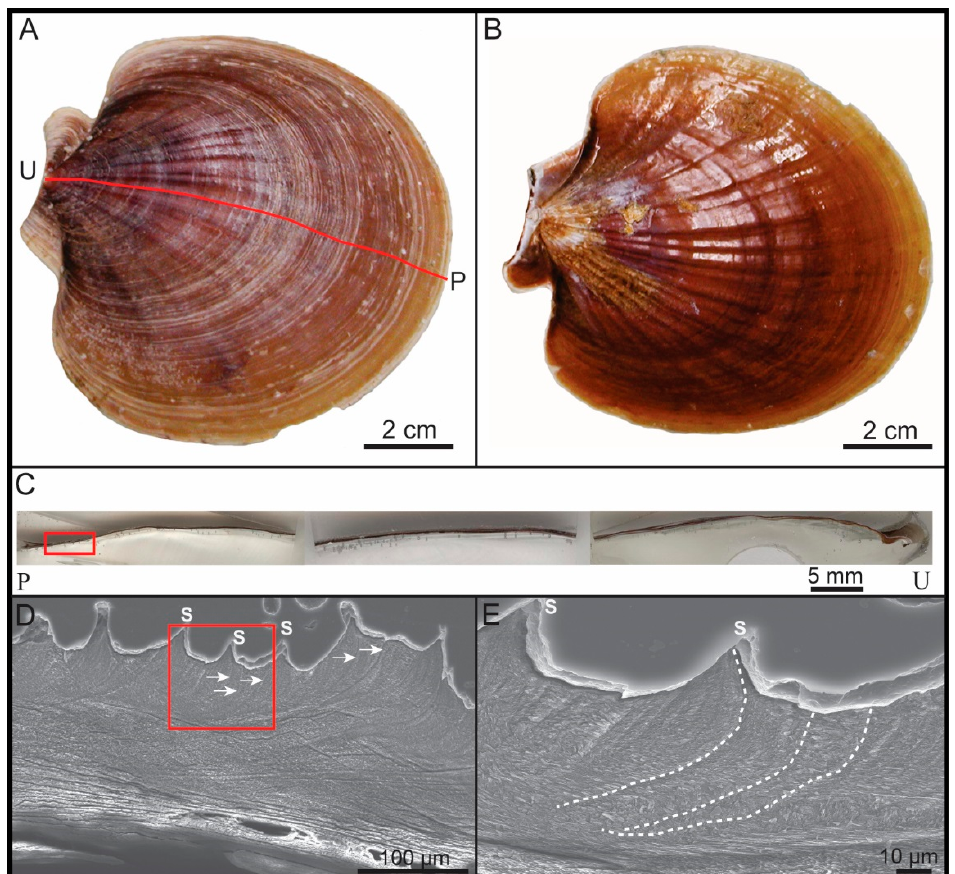
Figure 1. Antarctic scallop ( Adamussium colbecki ) shell. ( A ) Top view of a right valve used in this study. Note: the red line marks the section taken along the shell length from the umbo region (U) to the posterior region (P). ( B ) Image of the shell interior of the same valve. ( C ) Shell regions polished and prepared for SEM (Scanning Electron Microscopy) and APT analyses. Note: The red rectangle marks the location of the shell analyzed. ( D ) SEM image of the shell surface showing the locations of surficial striae (S) and substrial growth lines (white arrows). ( E ) Detailed view of some substrial growth lines (dashed lines) from the marked area (red square in ( C )).